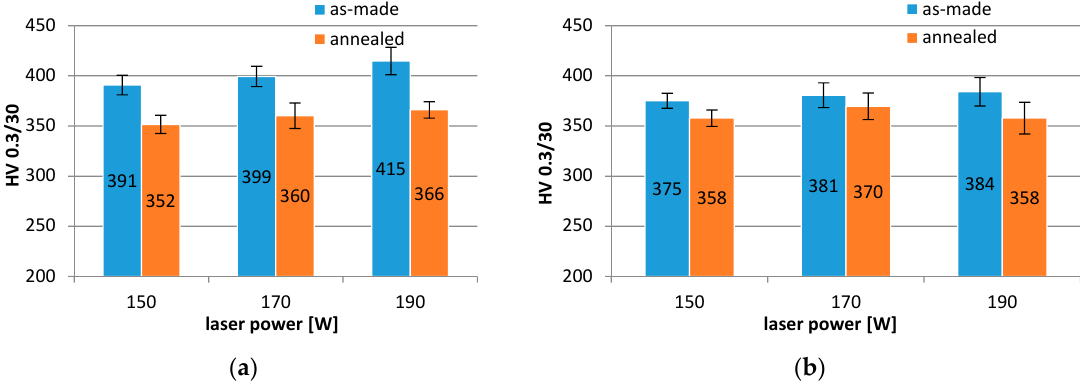
Figure 9. Hardness of materials depending on the laser power and the direction. ( a ) Perpendicular to deposited layers; ( b ) parallel with deposited layers.